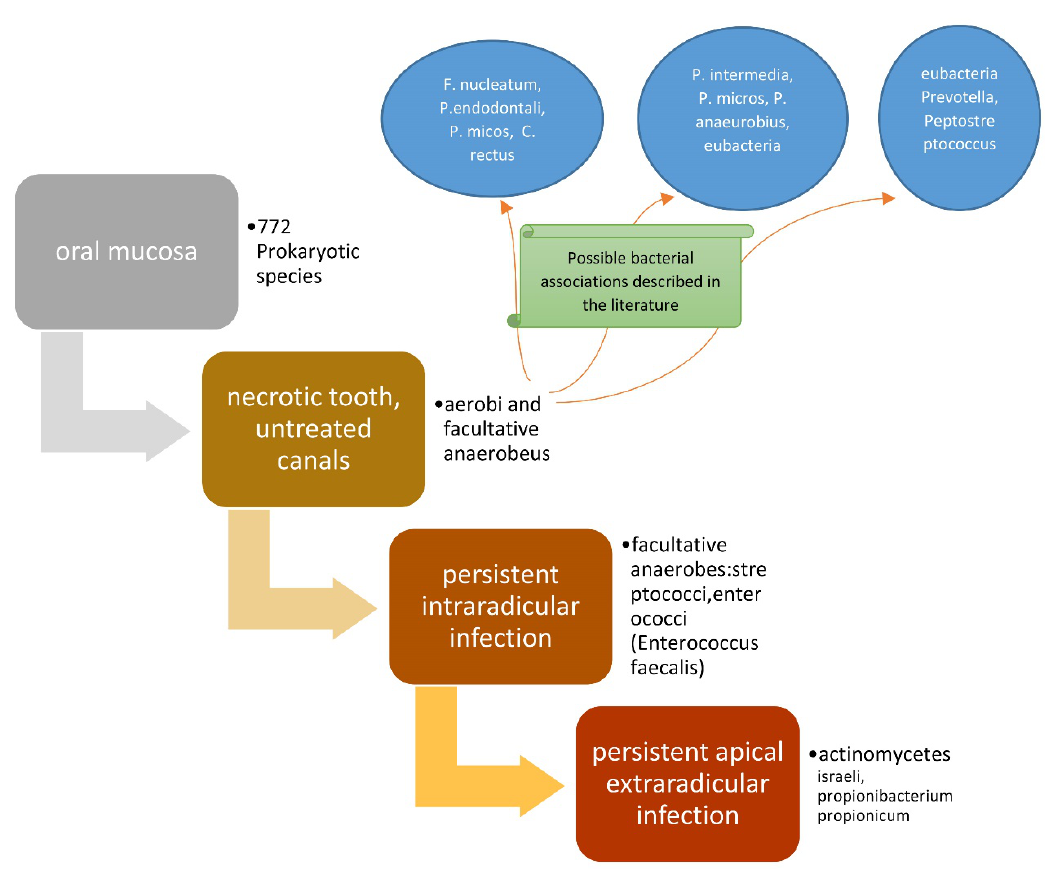
Figure 2. Scheme representing the roles of bacteria in endodontic diseases.